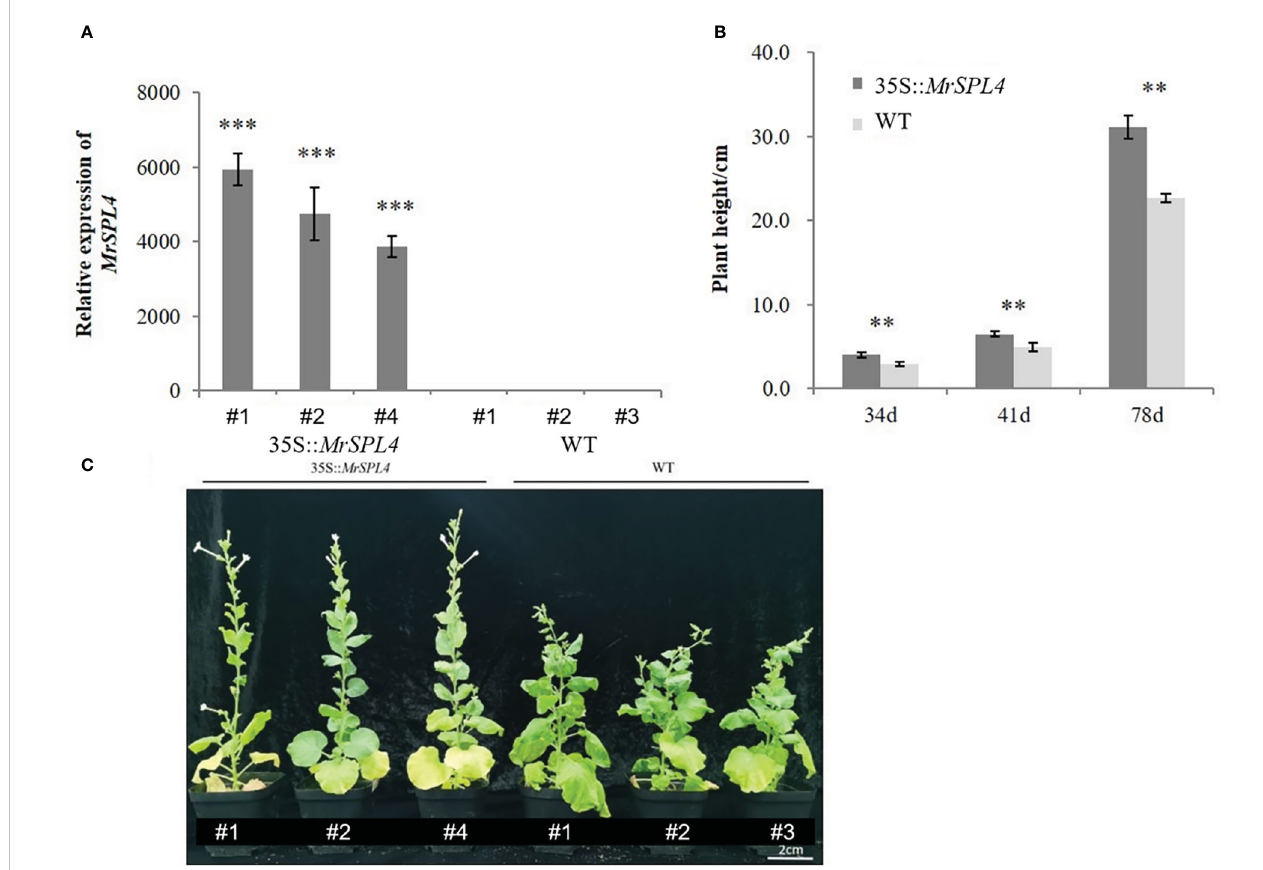
FIGURE 6 Analysis in the T 1 generation of positive tobacco lines. (A) MrSPL4 expression in positive and WT tobacco. (B) The plant height of positive and WT tobacco. 34d, 41d and 78d indicate the number of days after transplanting. (C) The phenotype of positive and WT tobacco. Values are the mean ( ± SD) of three replicates, ** indicates 0.001< p < 0.05, *** indicates p < 0.001 by the Student ’ s